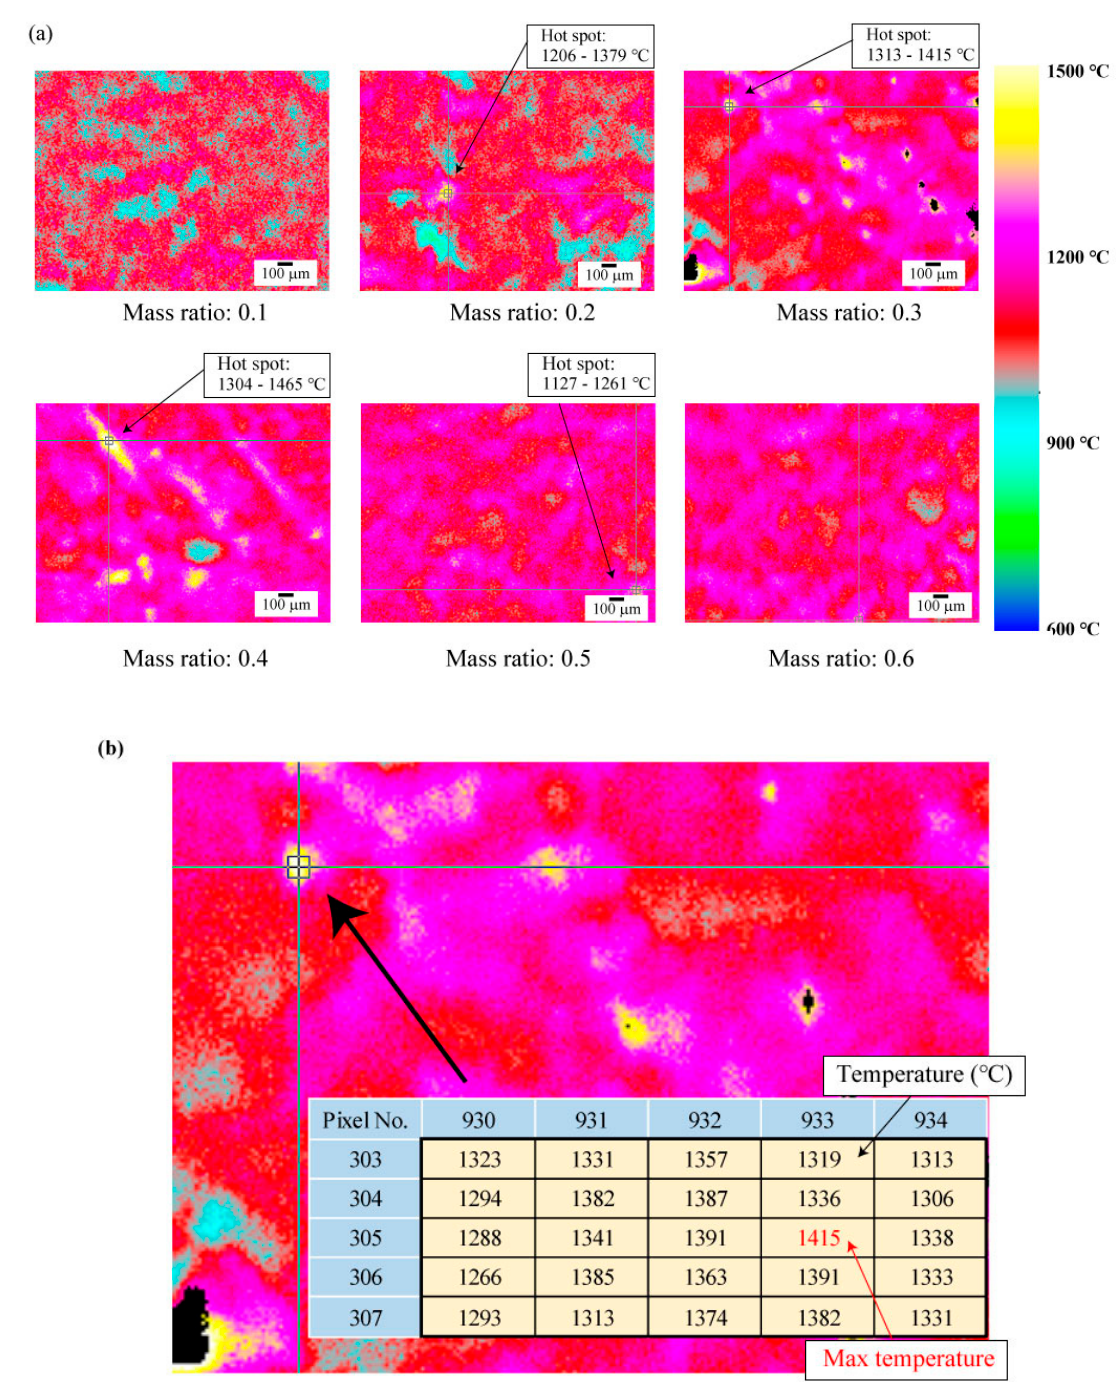
Figure 4. ( a ) Thermal distribution of each SiC fiber-ZrO 2 composition ( b ) and temperatures of each pixel for 70 mass% SiC fiber-ZrO 2 composition. The fibers with micrometer-level length exhibit 500 °C higher temperatures than the surrounding medium. Note that the black regions indicate temperatures at ≥ 1500 °C. Here, the approximate size of one pixel is 2.2 μ m.